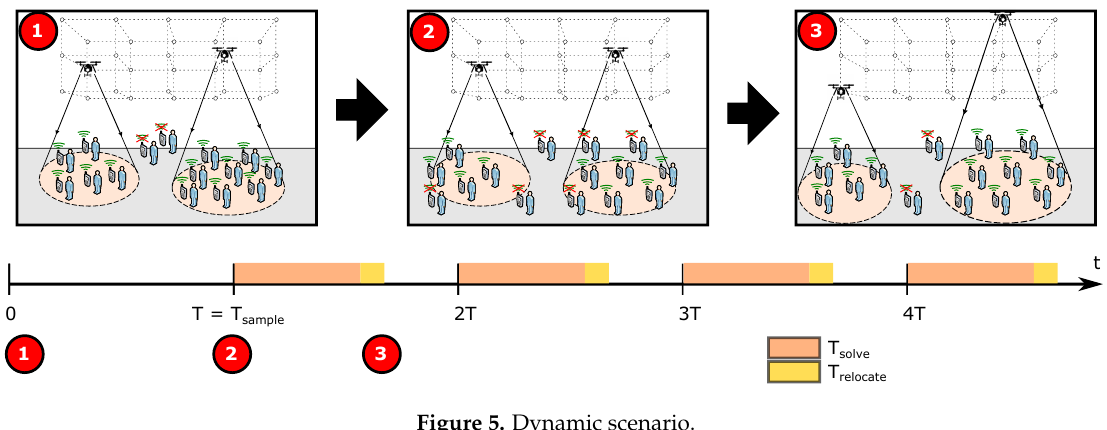
Figure 5. Dynamic